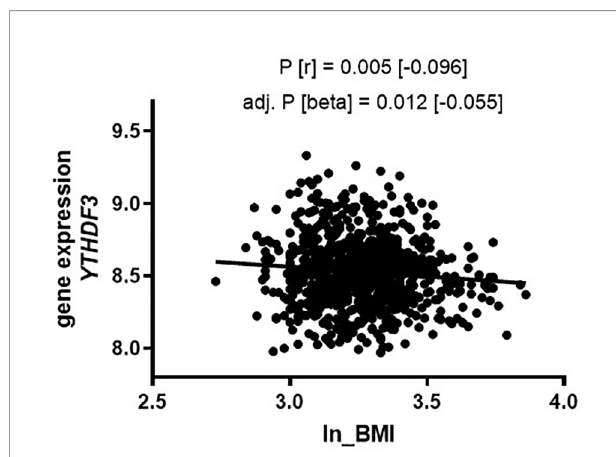
FIGURE 4 | Gene expression of YTHDF3 (PBMCs) in the Sorbs cohort correlates with BMI. Correlation of gene expression with BMI in the Sorbs population in non-diabetic subjects ( N =875). P -values were calculated by using bivariate Spearman correlation (top P -value) and linear regression analysis for ln_BMI adjusted for age and sex (bottom line). BMI, body mass index; Beta=non-standardized regression coef fi cient from linear regression; P = P -value, r=correlation coef fi cient from bivariate